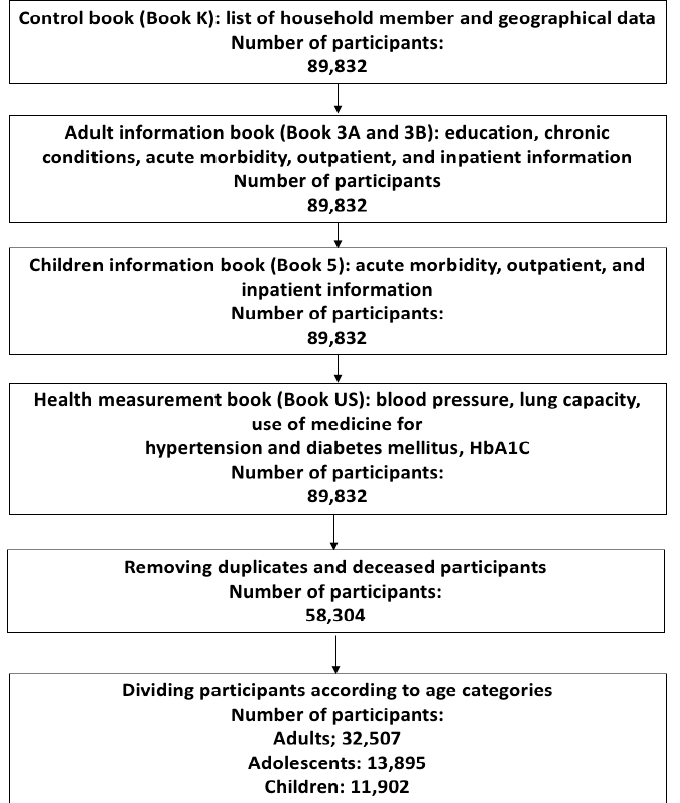
Figure 1. Data source, extraction, and merging steps.